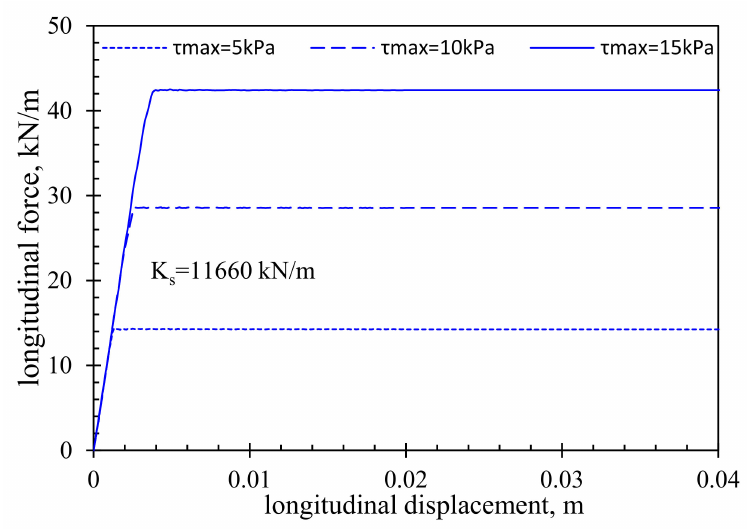
Figure 5. Longitudinal soil–pipe force–displacement curves for contact friction coefficients of 0.2, 0.3, and 0.4 in pull-out tests by the 3D solid